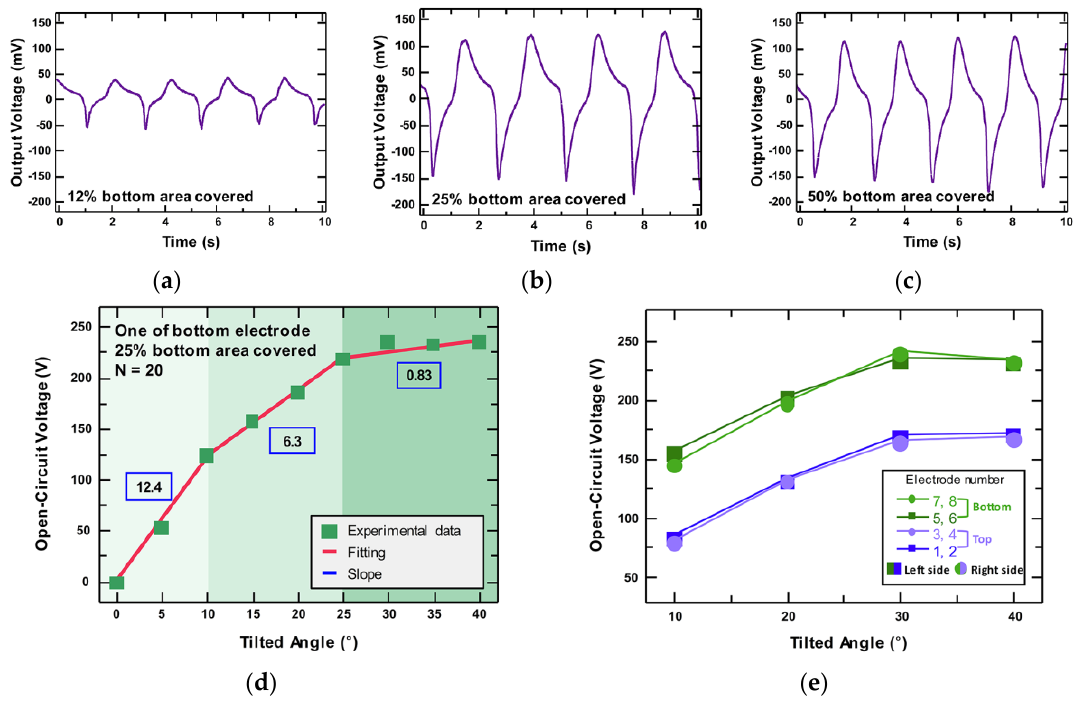
Figure 4. ( a – c ) The DAQ output voltage according to the number of PTFE balls occupying the bottom surface. The tilting angle and frequency are 20° and 0.5 Hz, respectively: ( a ) The amount of balls filled 12% of the bottom surface. ( b ) The amount of balls filled 25% of the bottom surface. ( c ) The amount of balls filled 50% of the bottom surface. ( d ) The open-circuit voltage of the bottom side with 25% amount of balls according to the tilting angle. ( e ) The open-circuit voltage of the bottom side and the top side.